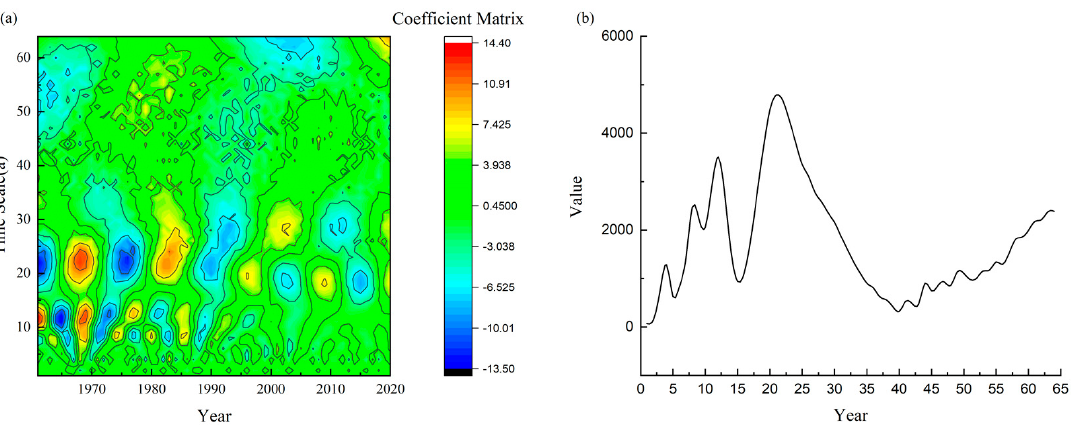
Figure 10. Contour map of the real part of the wavelet coefficients ( a ) and the wavelet variance ( b ) of the aridity index in Xinjiang.